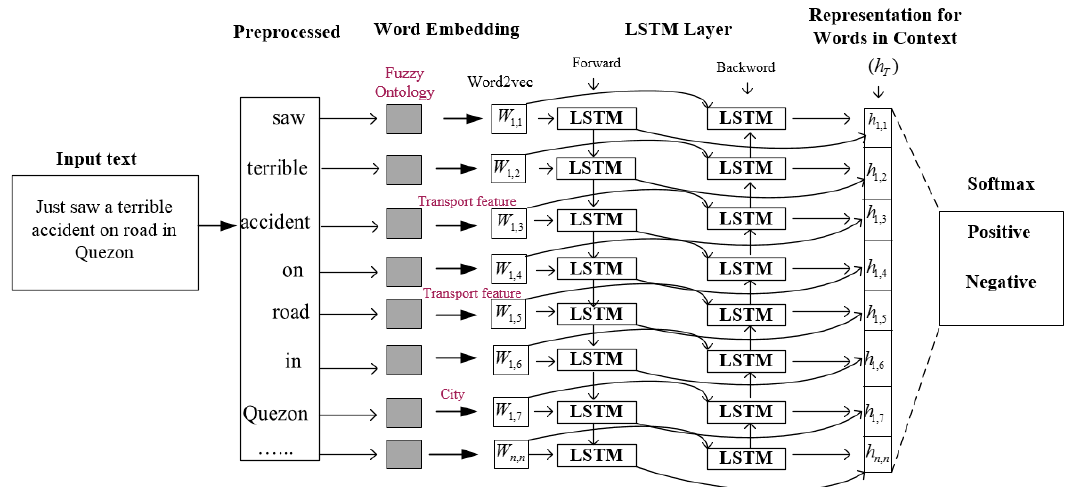
Figure 7. Word embedding and LSTM-based text classification.